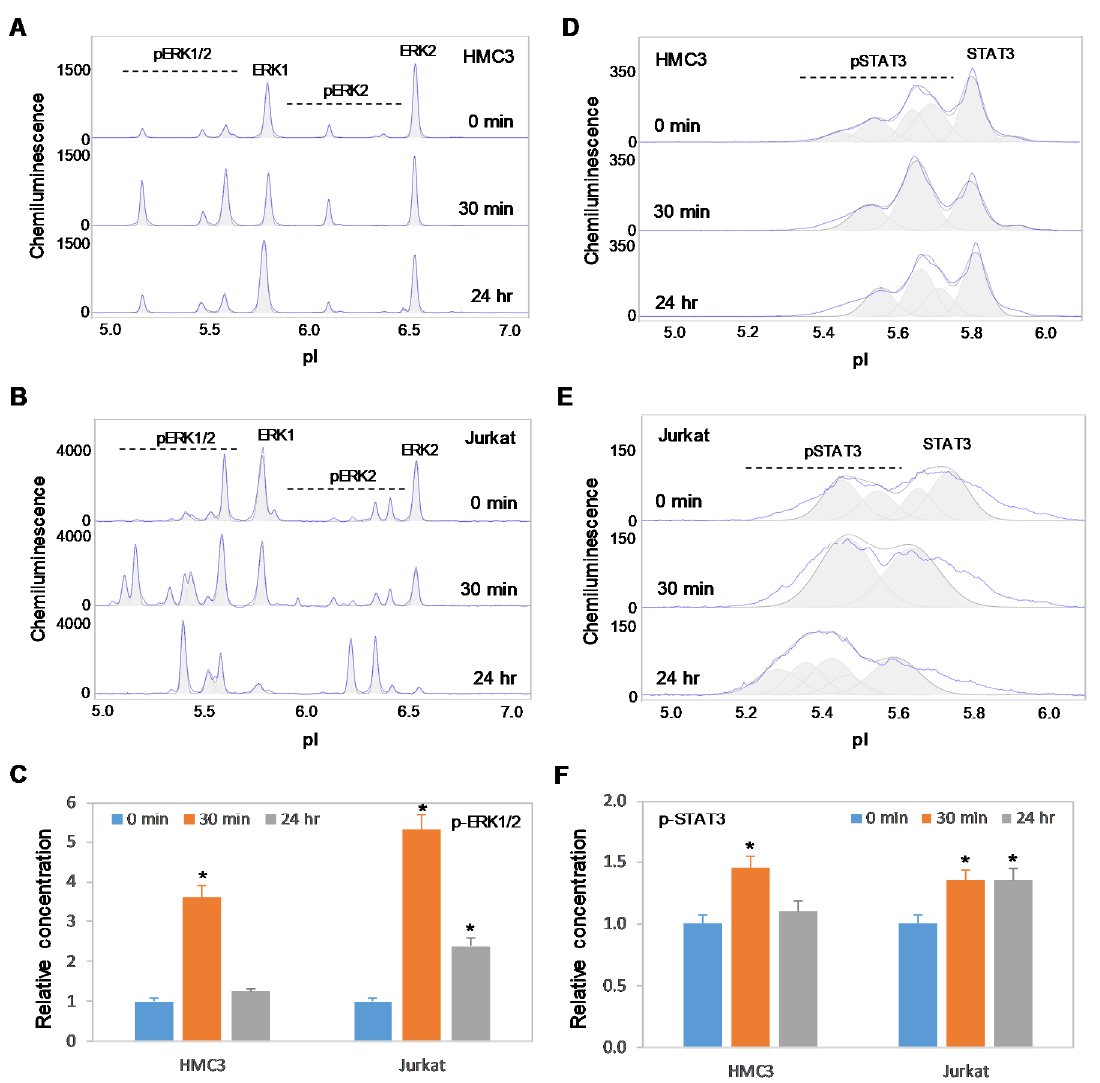
Figure 8. Positive regulation of the MAPK and JAK/STAT signaling pathways in immune cells by copaiba essential oils. ( A , B ) cIEF electropherograms of ERK1/2 in (A) HMC3 microglial cells and (B) Jurkat T-cells as a function of time after treatment with copaiba essential oil. ( C ) Relative concentrations of ERK1/2 phosphoisoforms as a function of time after treatment. ( D , E ) cIEF electropherograms of STAT in (D) HMC3 cells and (E) Jurkat cells as a function of time after treatment with copaiba essential oil. ( F ) Relative concentrations of STAT3 as a function of time after treatment. The relative concentration describes the fold change in the expression level of a protein phosphoisoform after treatment compared to that under the control condition. The error bars indicate the standard deviations of six repeated measurements per experimental condition. The asterisks indicate a statistical significance of p ≤ 0.05 versus the control. HMC3 and Jurkat cells were treated with 100 ng/mL copaiba essential oil.